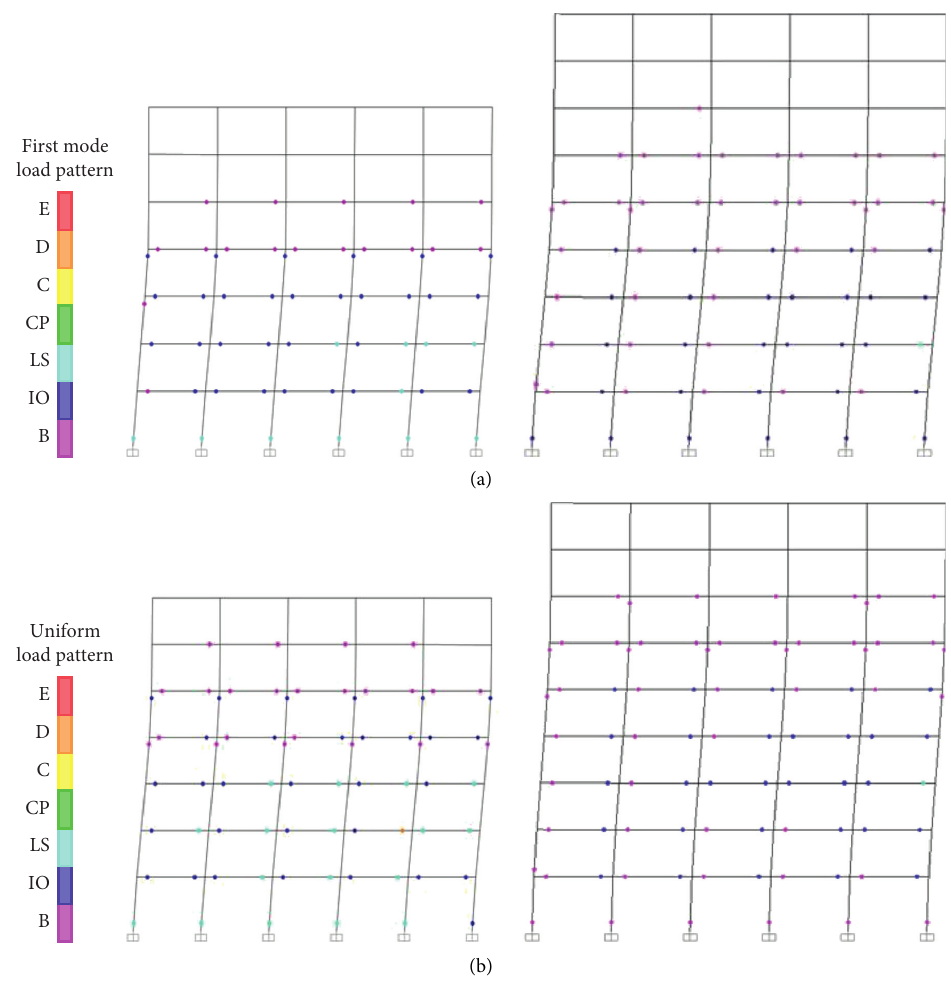
Figure 8: Collapse mechanism and distribution of plastic hinges at Life Safety Limit State. Pushover analysis of 5-bay RC frames.